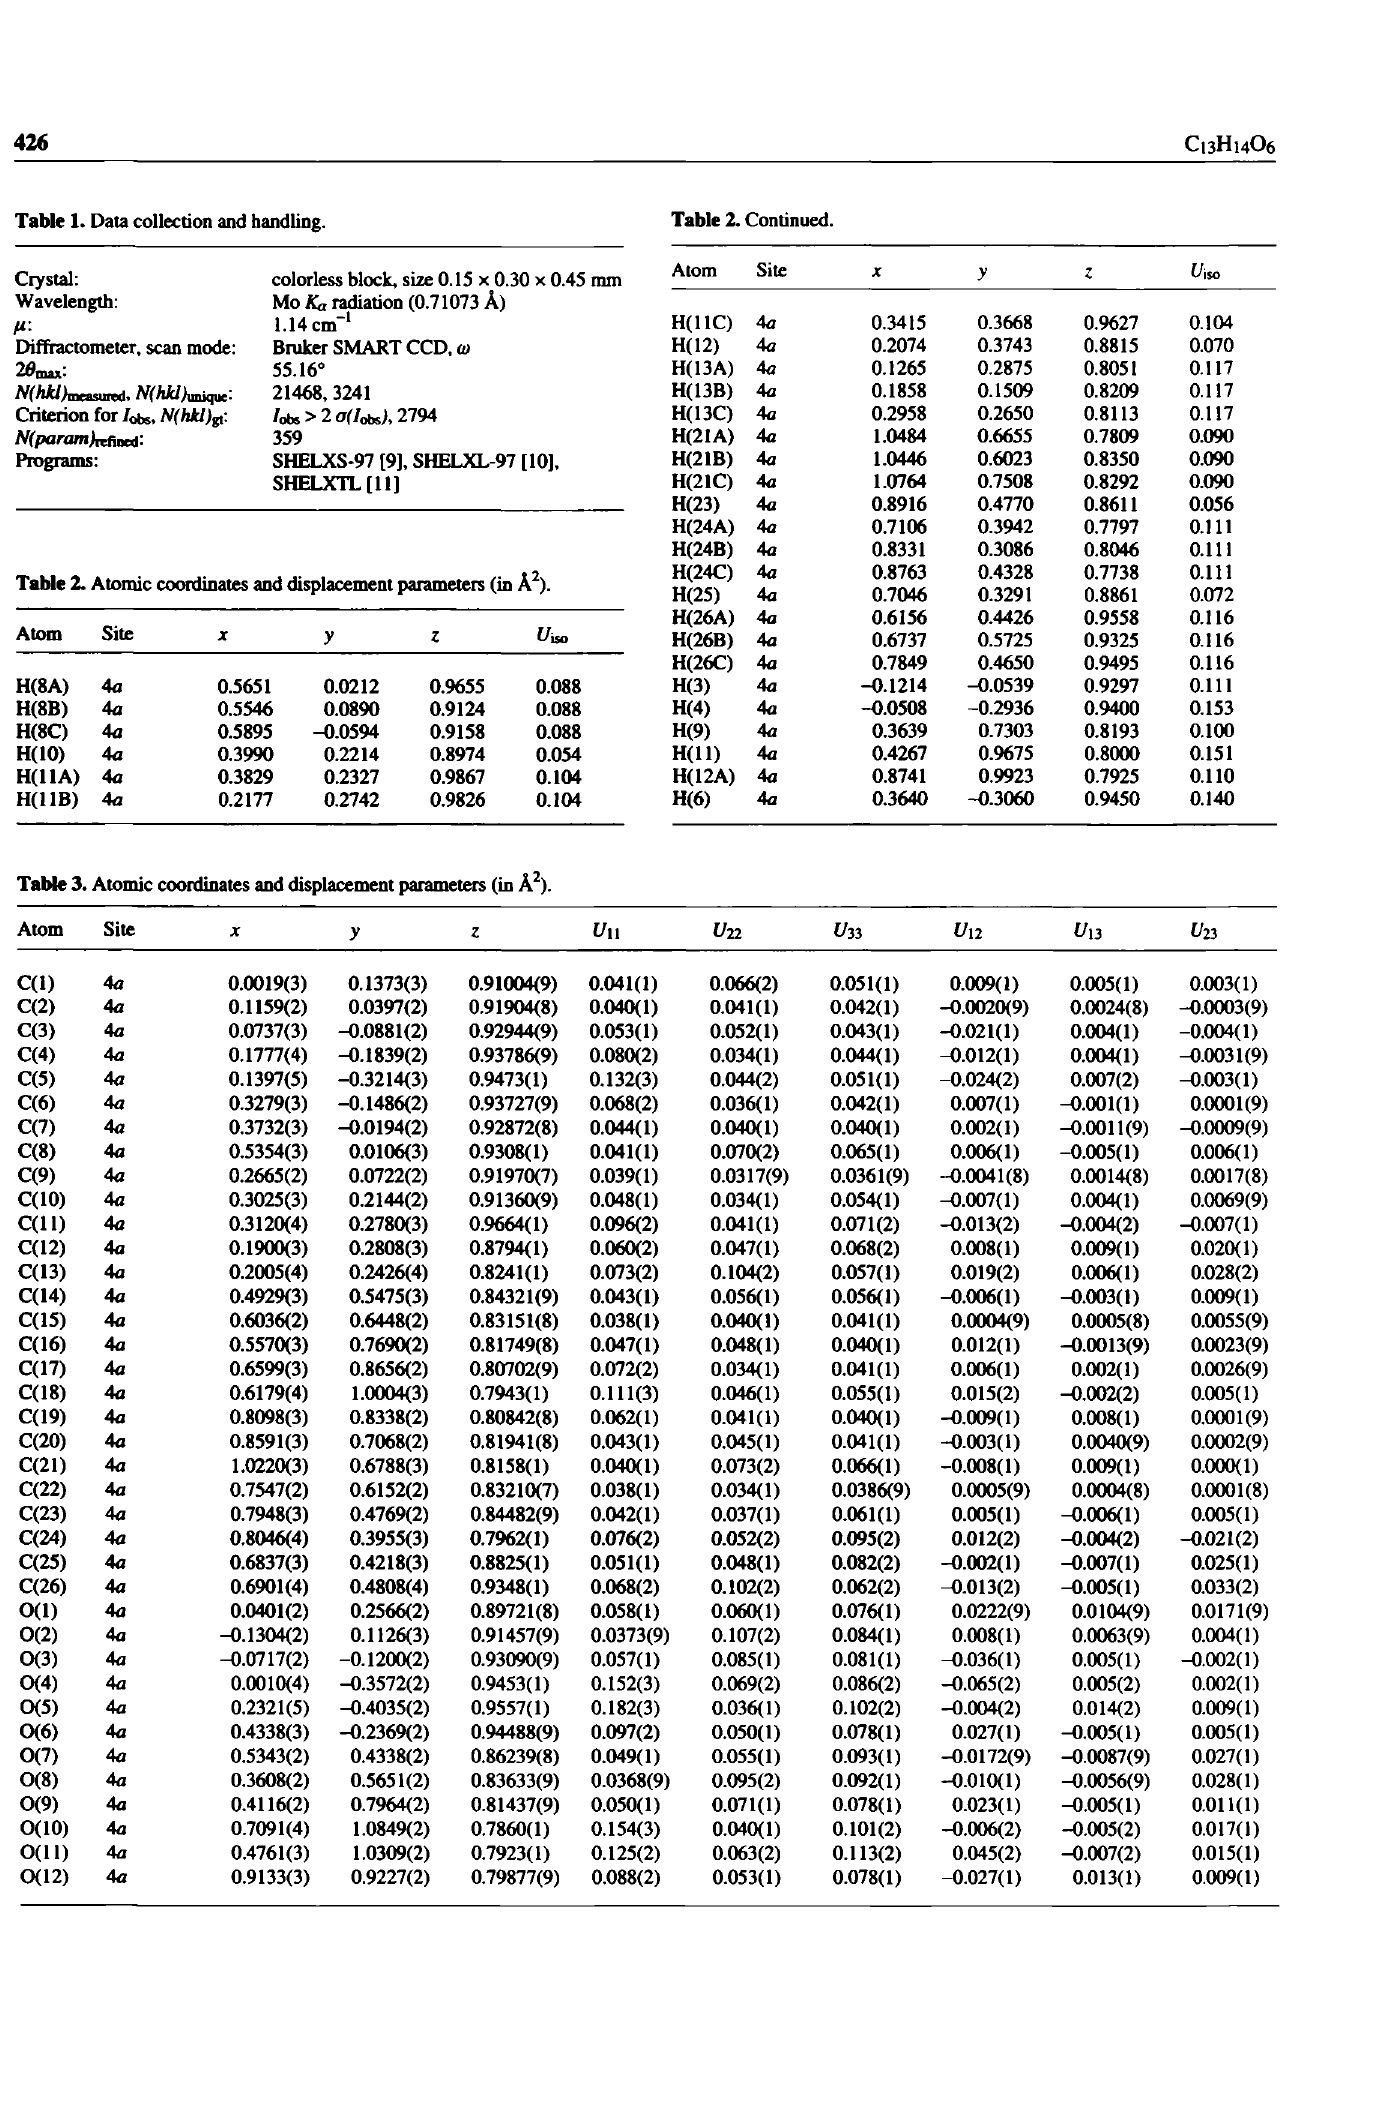
Table 2. Atomic coordinates and displacement parameters (in À 2 ).